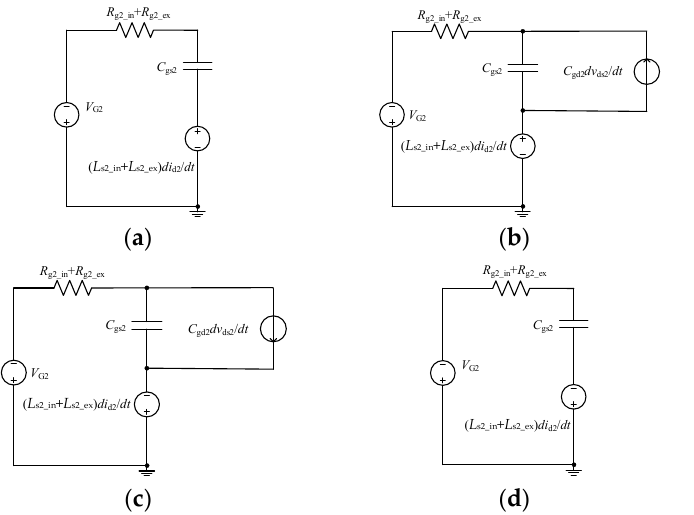
Figure 4. Equivalent circuit during Q 1 turn-ON and turn-OFF transition. ( a ) Stage 2, ( b ) Stage 3, ( c ) Stage 7 and ( d ) Stage 8.